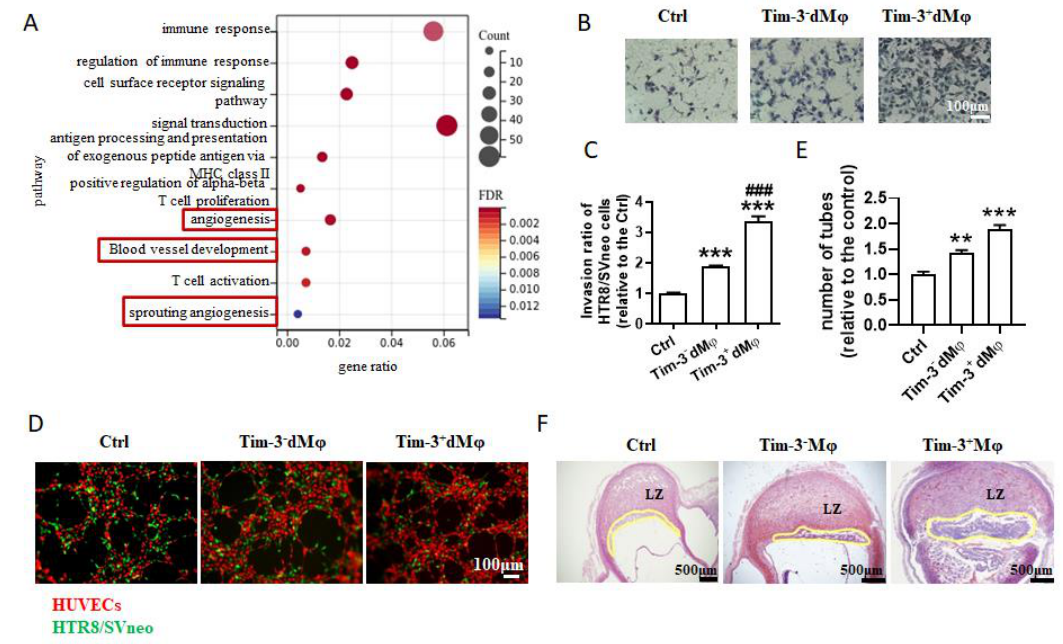
Figure 2. Tim-3 + dMφs were more beneficial to promote invasion and tube formation ability of trophoblasts. ( A ) Enriched Gene Ontology term pathways of differential gene clustering between Tim-3 − dM ϕ s and Tim-3 + M ϕ s from human normal first-trimester pregnancy. ( B , C ) Matrigel invasion assays of HTR8/Svneo cells following treatment of Tim-3 − dM ϕ s or Tim-3 + dM ϕ s. Data represent the mean ± SEM. ** p < 0.01, *** p < 0.001, compared with the ctrl group. ### p < 0.001, compared with the group of Tim-3 − dM ϕ . ( D , E ) Immunofluorescent assay at 4 h of the 3D tube formation by HTR8/SVneo cells (green) and HUVECs (red) with indicated treatments. ( F ) H&E-stained placental hemisections from pregnant mice with Mφ depletion and adoptive transfer of Tim -3 + Mφs or Tim -3 - Mφs at GD 1 0.5, n = 3 – 6 mice per group.